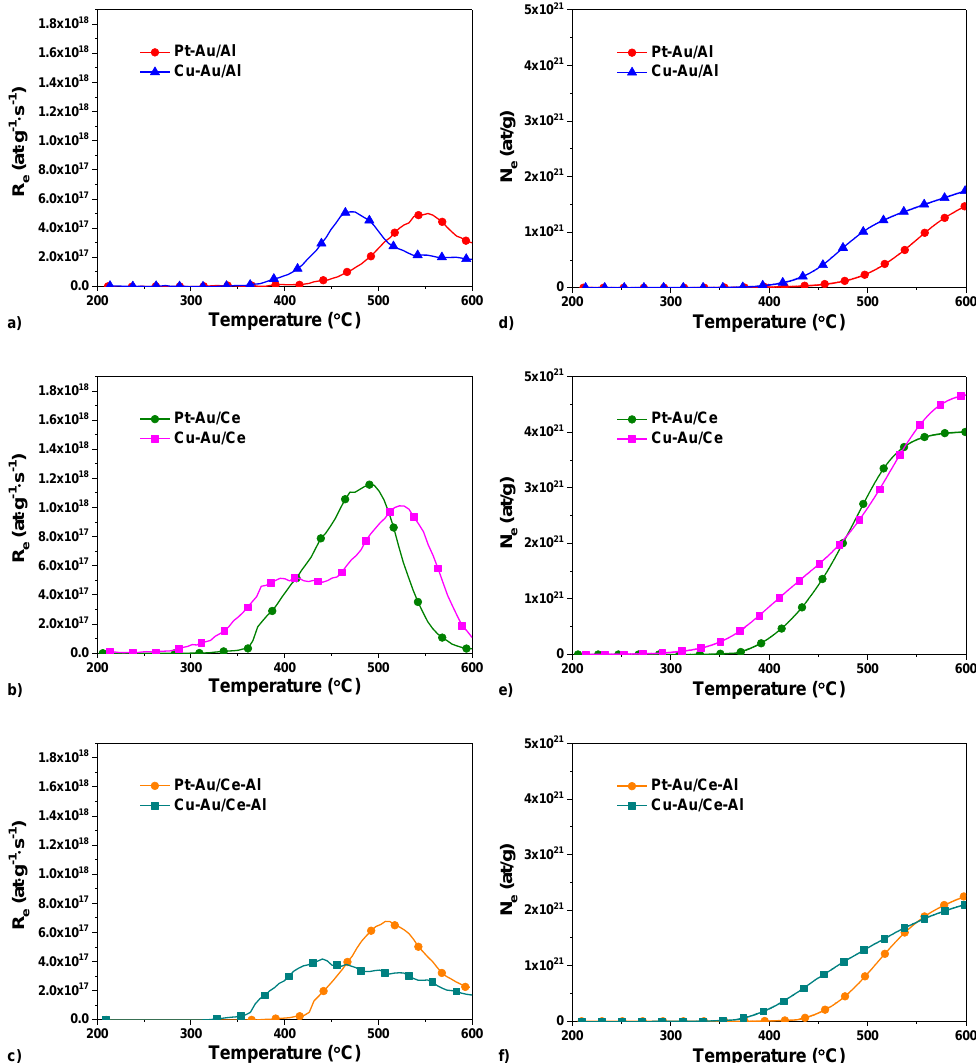
Figure 8. Evolution of the rate of oxygen exchange for Pt – Au and Cu – Au on ( a ) γ -Al 2 O 3 , ( b ) CeO 2 , and ( c ) CeO 2 – Al 2 O 3 catalysts ( R e = rate of oxygen exchange) and evolution of the number of exchanged oxygen atoms for Pt – Au and Cu – Au on ( d ) γ -Al 2 O 3 , ( e ) CeO 2 , and ( f ) CeO 2 – Al 2 O 3 catalysts ( N e = number of exchanged oxygen atoms) in thermally programmed isotopic exchange (TPIE) experiments with labeled oxygen ( 18 O 2 ).